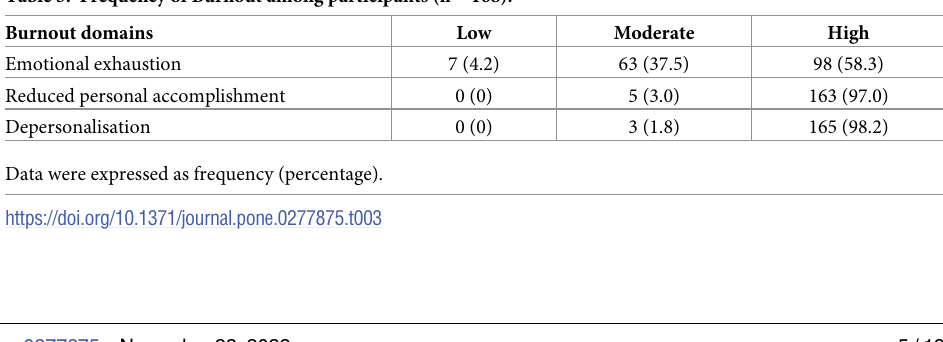
Table 3. Frequency of Burnout among participants (n =